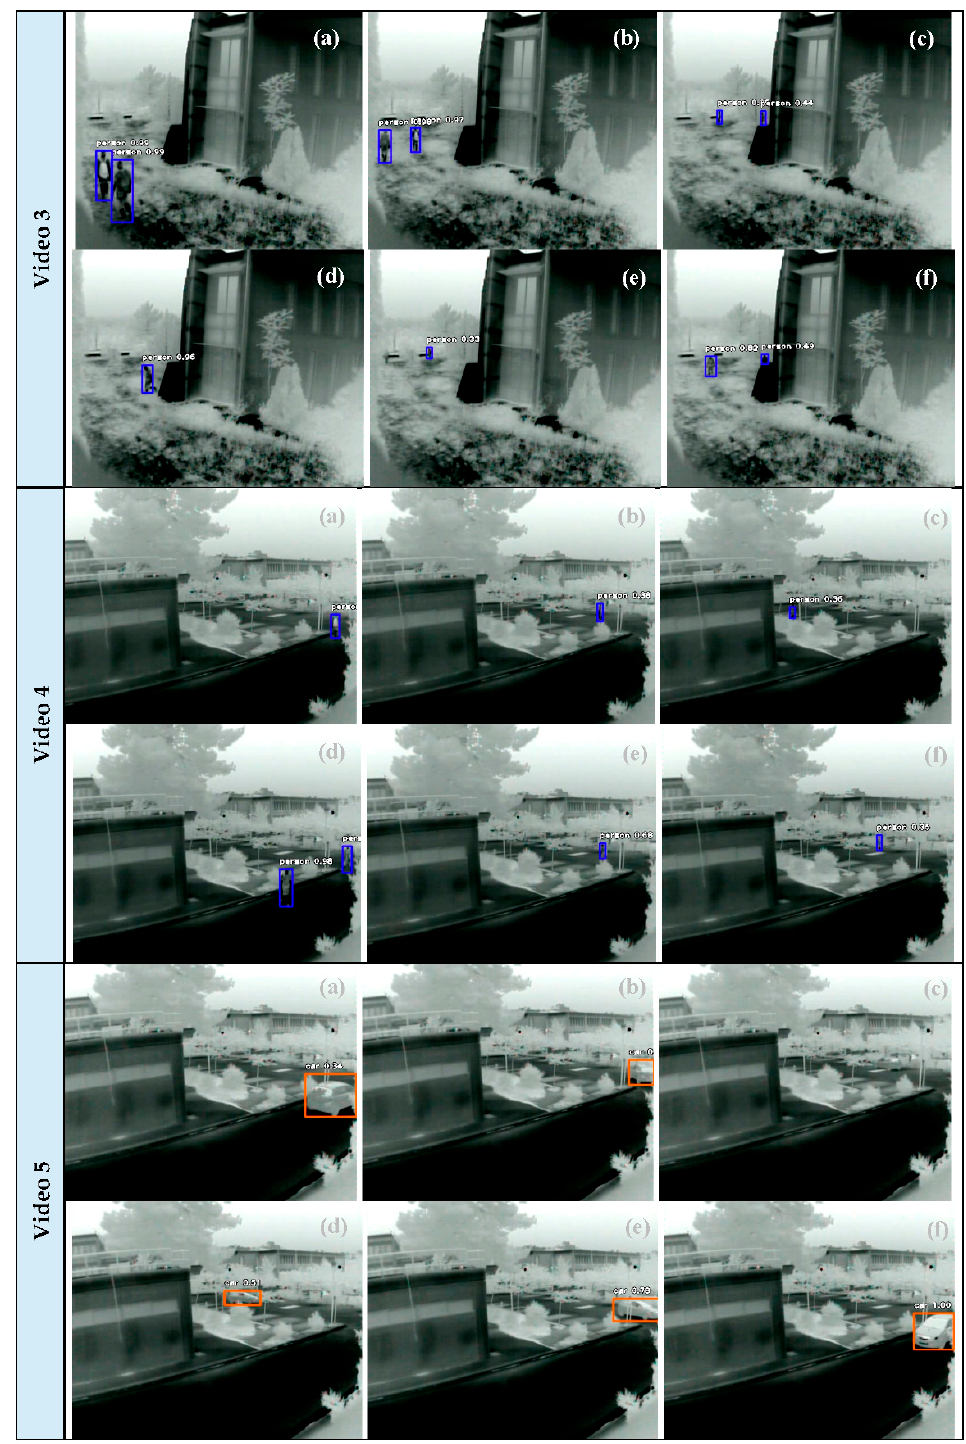
Figure 16. Object detection results (persons in blue rectangles and cars in orange rectangles) for the terrestrial asset using the thermal camera as time progresses (frames ( a – f )).